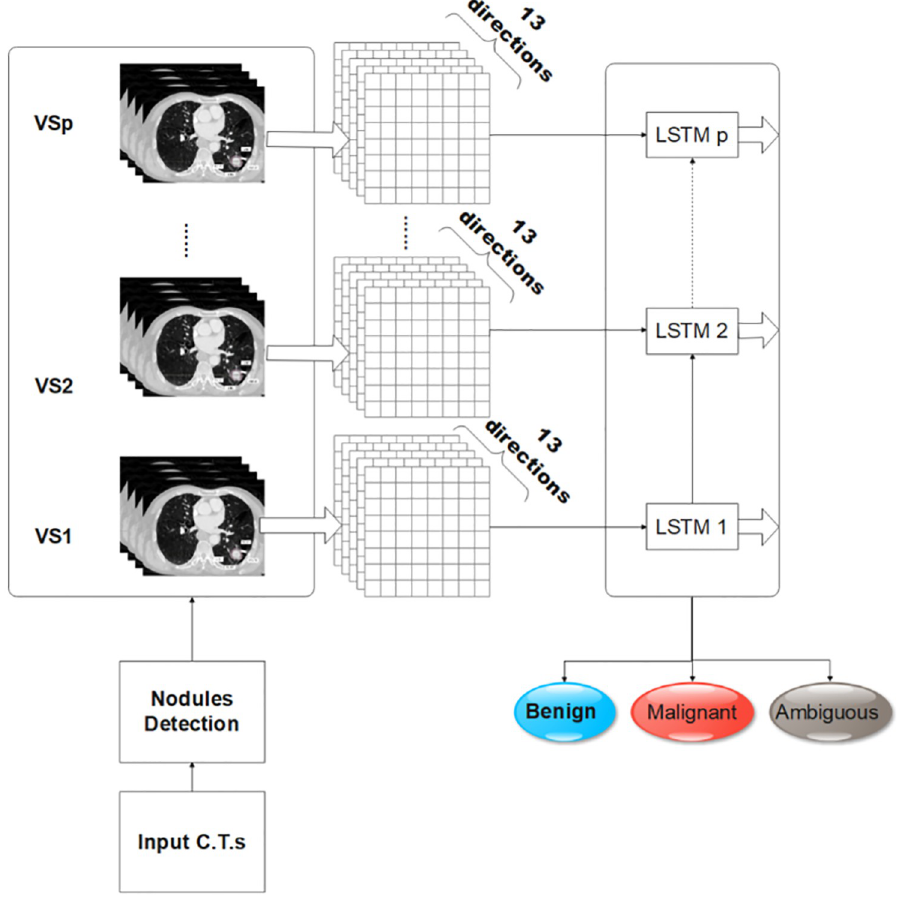
Fig 3. The 3D-GLCMs are computed from VSs of nodule volume and fed to a recurrent neural network.